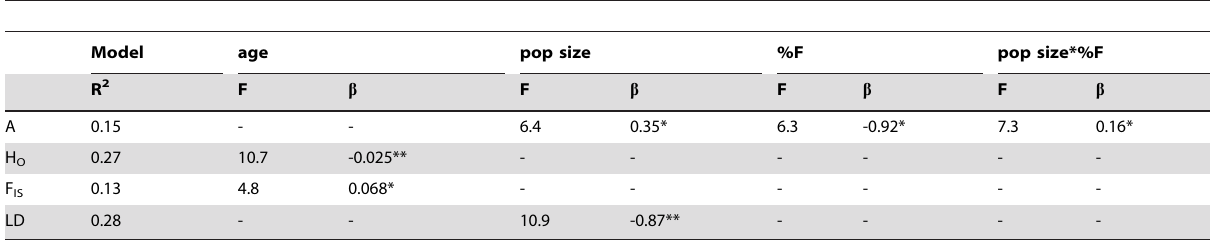
Table 2. Parameter estimates of the final GLM analyses after model reduction (n=27).